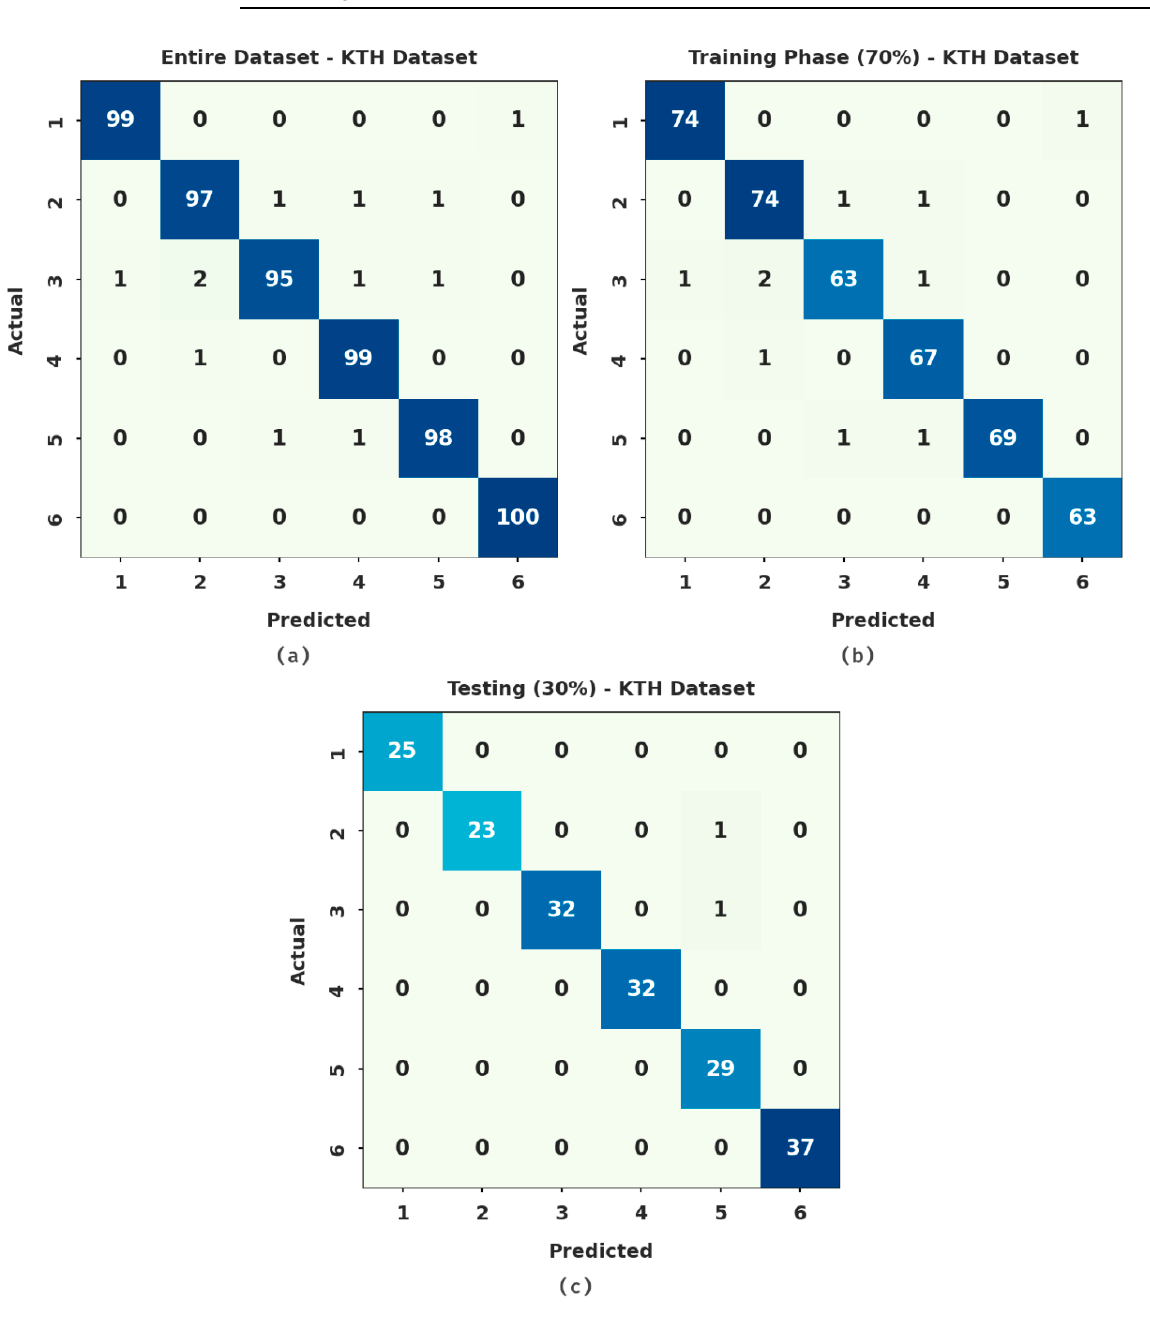
Figure 3. Confusion matrix of QWSA-HDLAR model on KTH dataset.